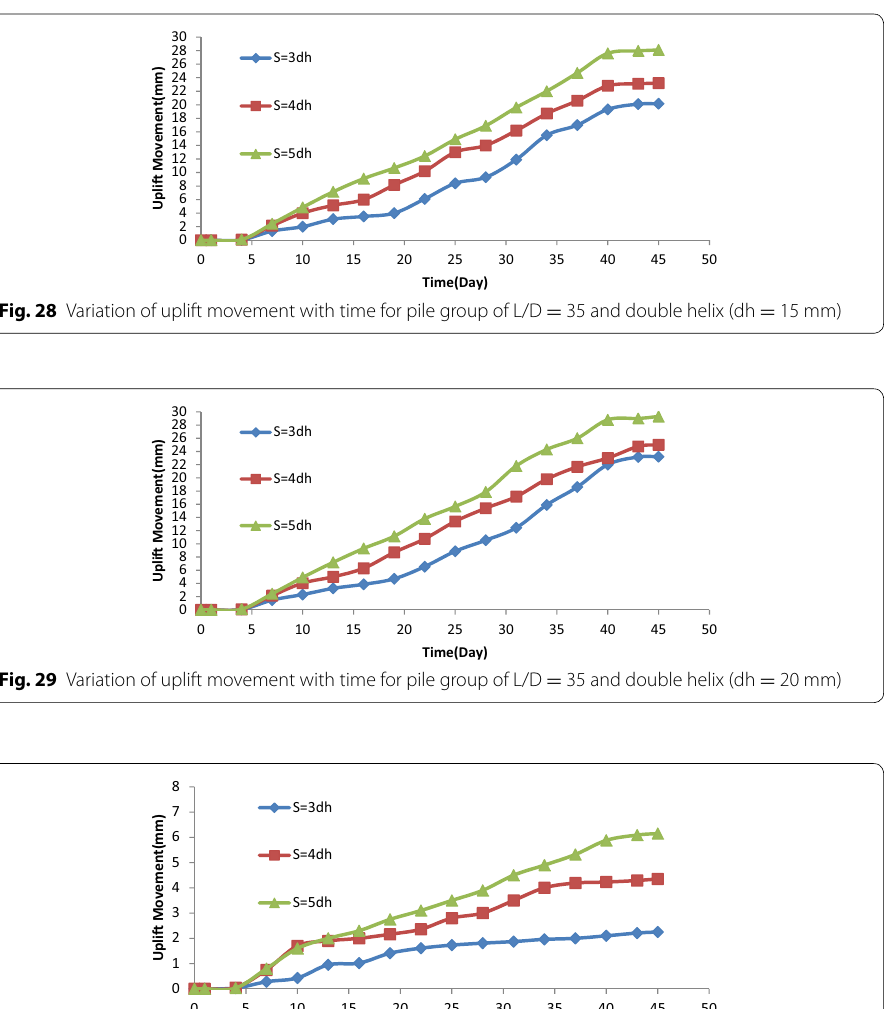
53 and single helix (dh =